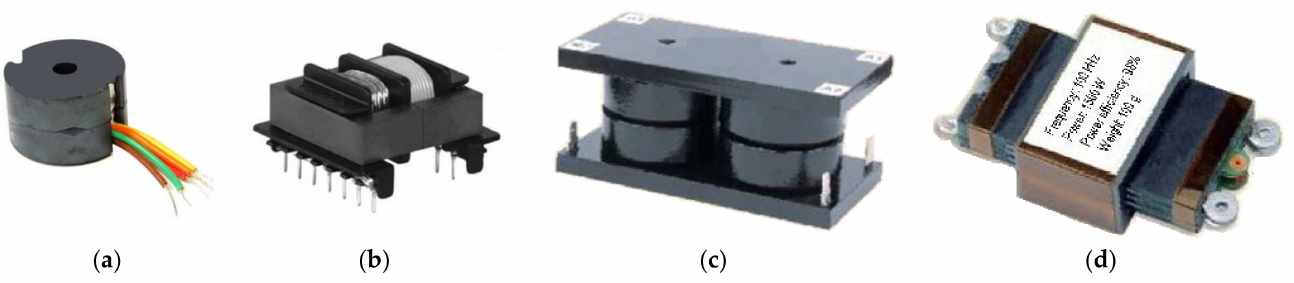
Figure 8. HF transformers used for LLC resonate converter and PSFB converter and their magnetic core structures. ( a ) Pot-core transformer ( b ) Shell-type transformer ( c ) Coaxial transformer ( d ) Planar